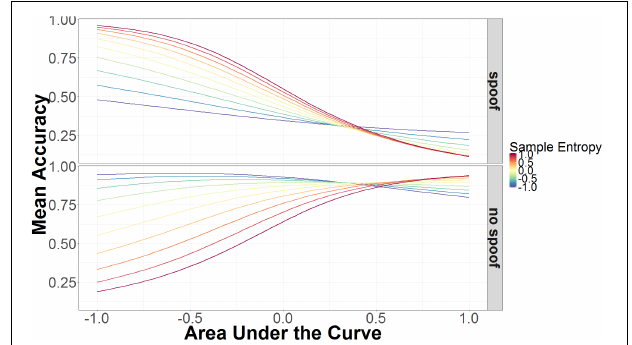
FIGURE 6 | Mean accuracy as a function of AUC and SE in spoof and non-spoof conditions. The data on the x-axis are normalized and range from 2 SD below the mean ( − 1.00) to 2 SD above the mean ( +